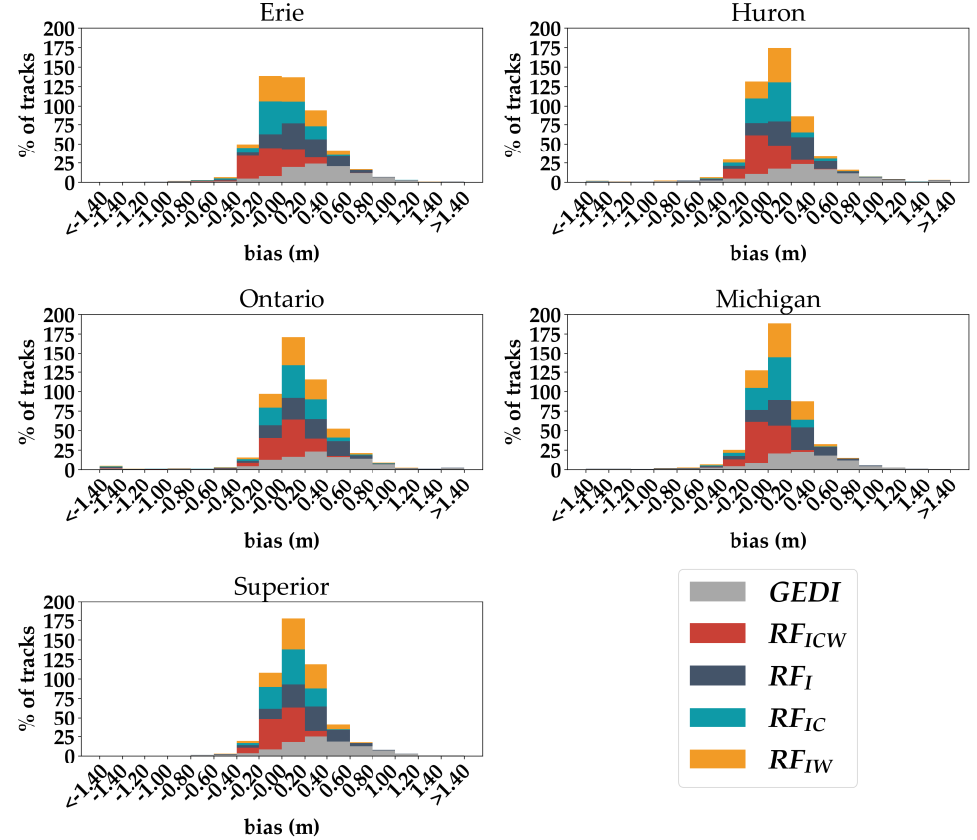
Figure 11. Stacked histograms of the distribution of the mean difference (bias) between GEDI (resp. RF ICW , RF I , RF IC , and RF IW ) and in situ elevations across the five studied lakes. Biases correspond to the mean difference calculated for GEDI shots grouped by acquisition date and the acquiring beam. Table 4. Summary statistics of the RMSE and ubRMSE on the estimation of water surface elevations